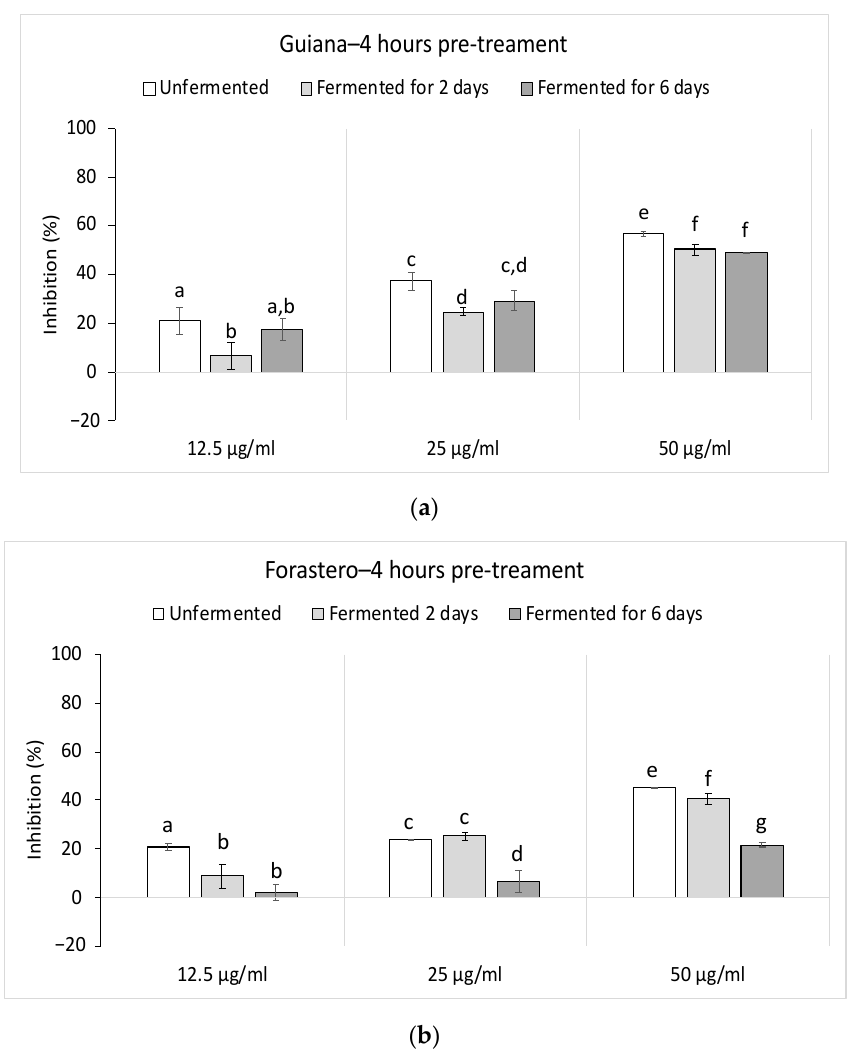
Figure 5. Inhibition rates of both varieties on interleukin-6 production in lipopolysaccharide (LPS) and interferon gamma (IFNγ )-stimulated macrophages. ( a ) Guiana, ( b ) Forastero. Results represent the mean % inhibition of IL-6 production ± SEM ( n = 4). At each concentration, histograms with the same letter a-g for ( a ) or ( b ) were not significantly different ( p < 0.05) using a Mann–Whitney U test.